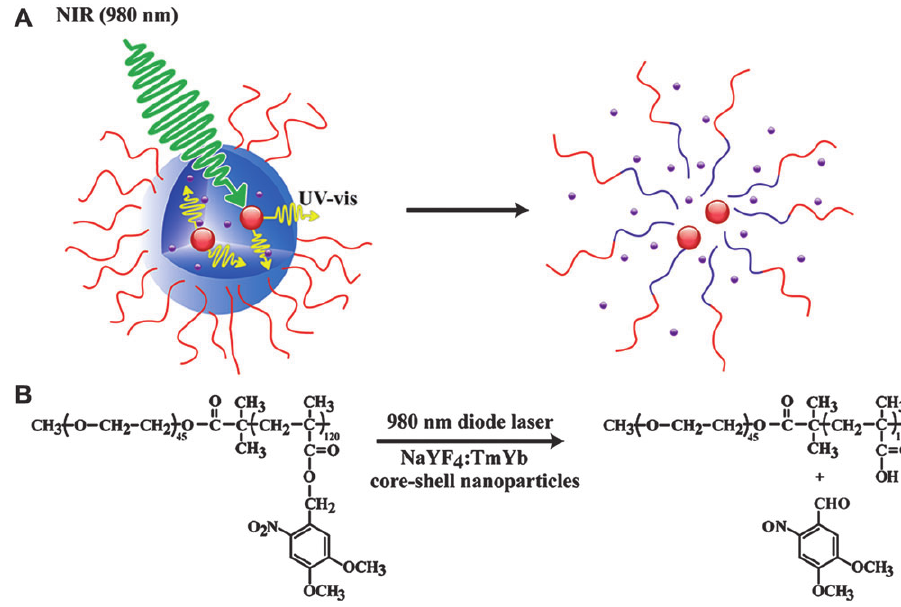
Figure 20 (A) Schematic illustration of using NIR light excitation of UCNPs to trigger dissociation of BCP micelles; (B) NIR-triggered pho- toreaction with the used BCP of PEO- b -PNBMA and UCNPs of NaYF4:TmYb [102] . Reprinted with permission from Ref. [102] . Copyright (2011) American Chemical Society.